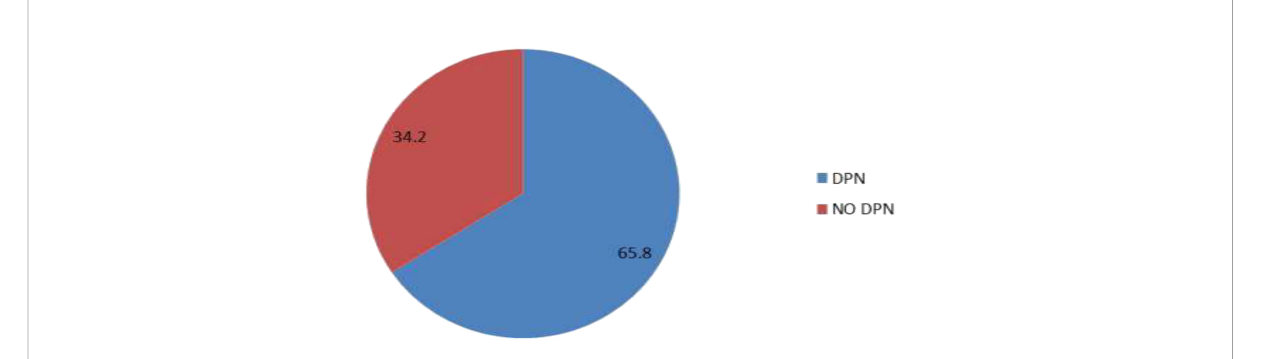
FIGURE 1 Prevalence of DPN among known DM patients attending